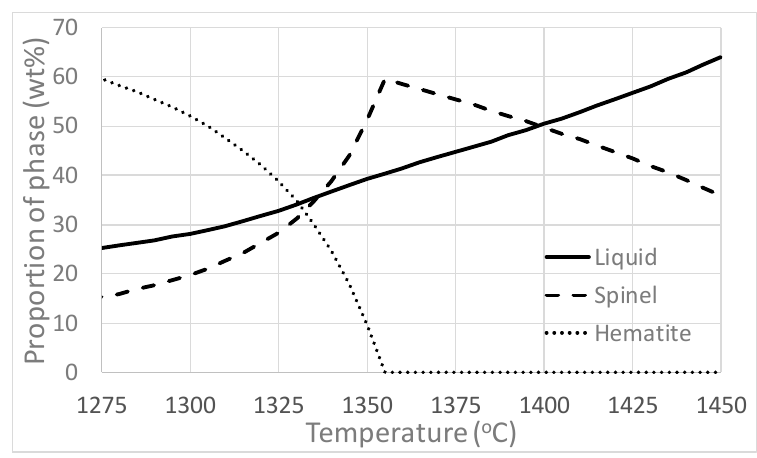
Figure 18. Variation in the proportion of phases present in the base case with temperature. Minerals 2019 , 9 , x FOR PEER REVIEW